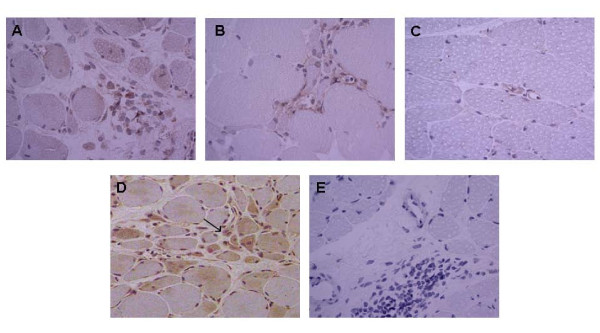
Expression of resistin in muscle tissue. Expression of resistin in affected skeletal muscle tissue from patients with dermatomyositis (a) and myositis (b) in contrast with no expression in the muscle tissue of myasthenia gravis (c). Expression of resistin in regenerating muscle fibres (pointed with arrow) in a patient with dermatomyositis (d). Corresponding tissue sections stained with isotype antibodies (e). Resistin appears as brown. Nuclei were stained with hematoxylin. Original magnification, ×400 (a-c, e) and ×200 (d).